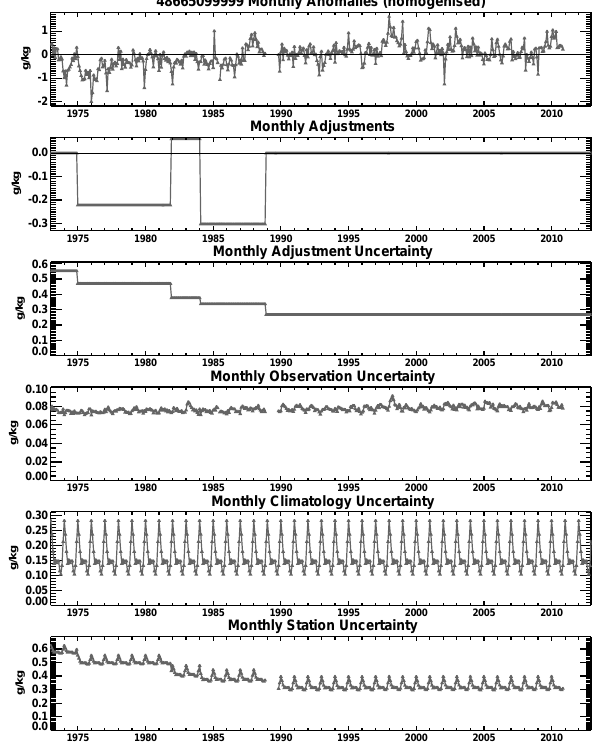
Fig. 7. The components of station uncertainty estimates for station 486650 (Malacca, Malaysia, 2.267 ◦ N, 102.250 ◦ E, 9.0m). All un- certainties represent 2 σ (approximately 95% confidence